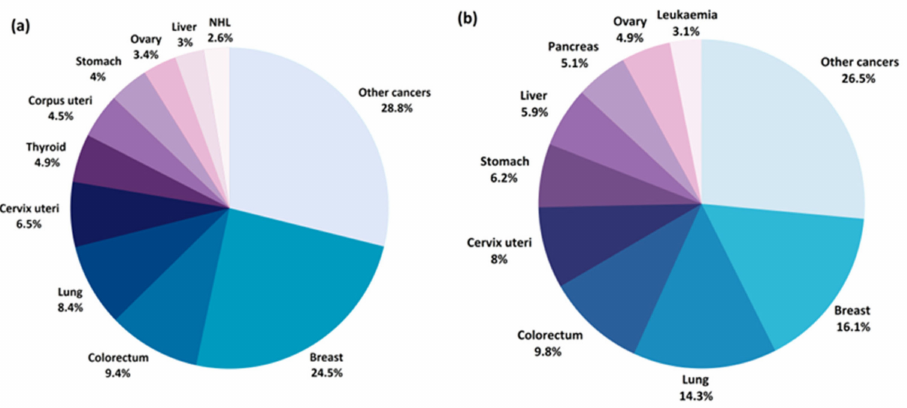
Figure 2. Estimated percentage of new cancer cases ( a ) and cancer deaths ( b ) worldwide for 2020